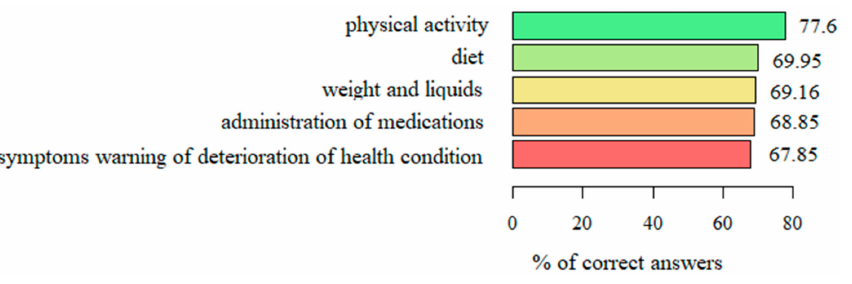
Figure 3. The level of knowledge regarding the specific subject areas.